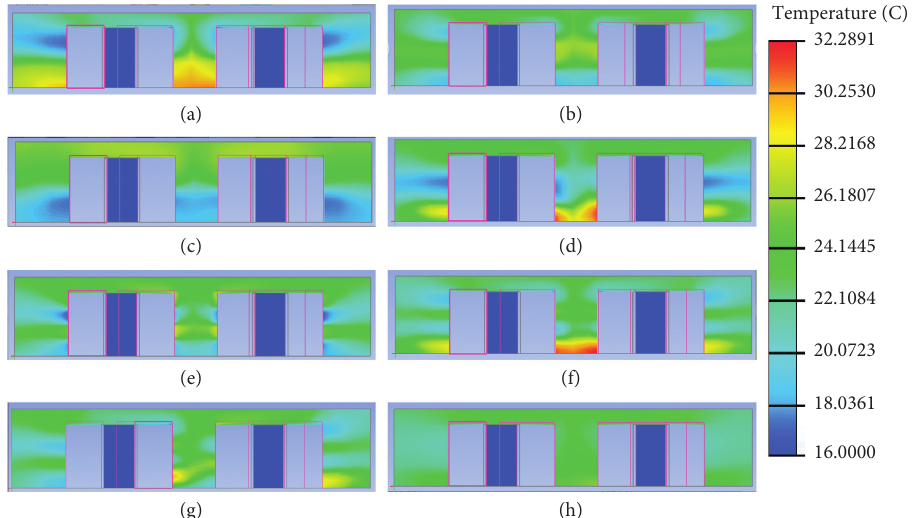
Figure 5: Temperature cloud diagram of different workload allocation at X � 7 m. (a) Model 1. (b) Model 2. (c) Model 3. (d) Model 4. (e) Model 5. (f) Model 6. (g) Model 7. (h) Model 8.